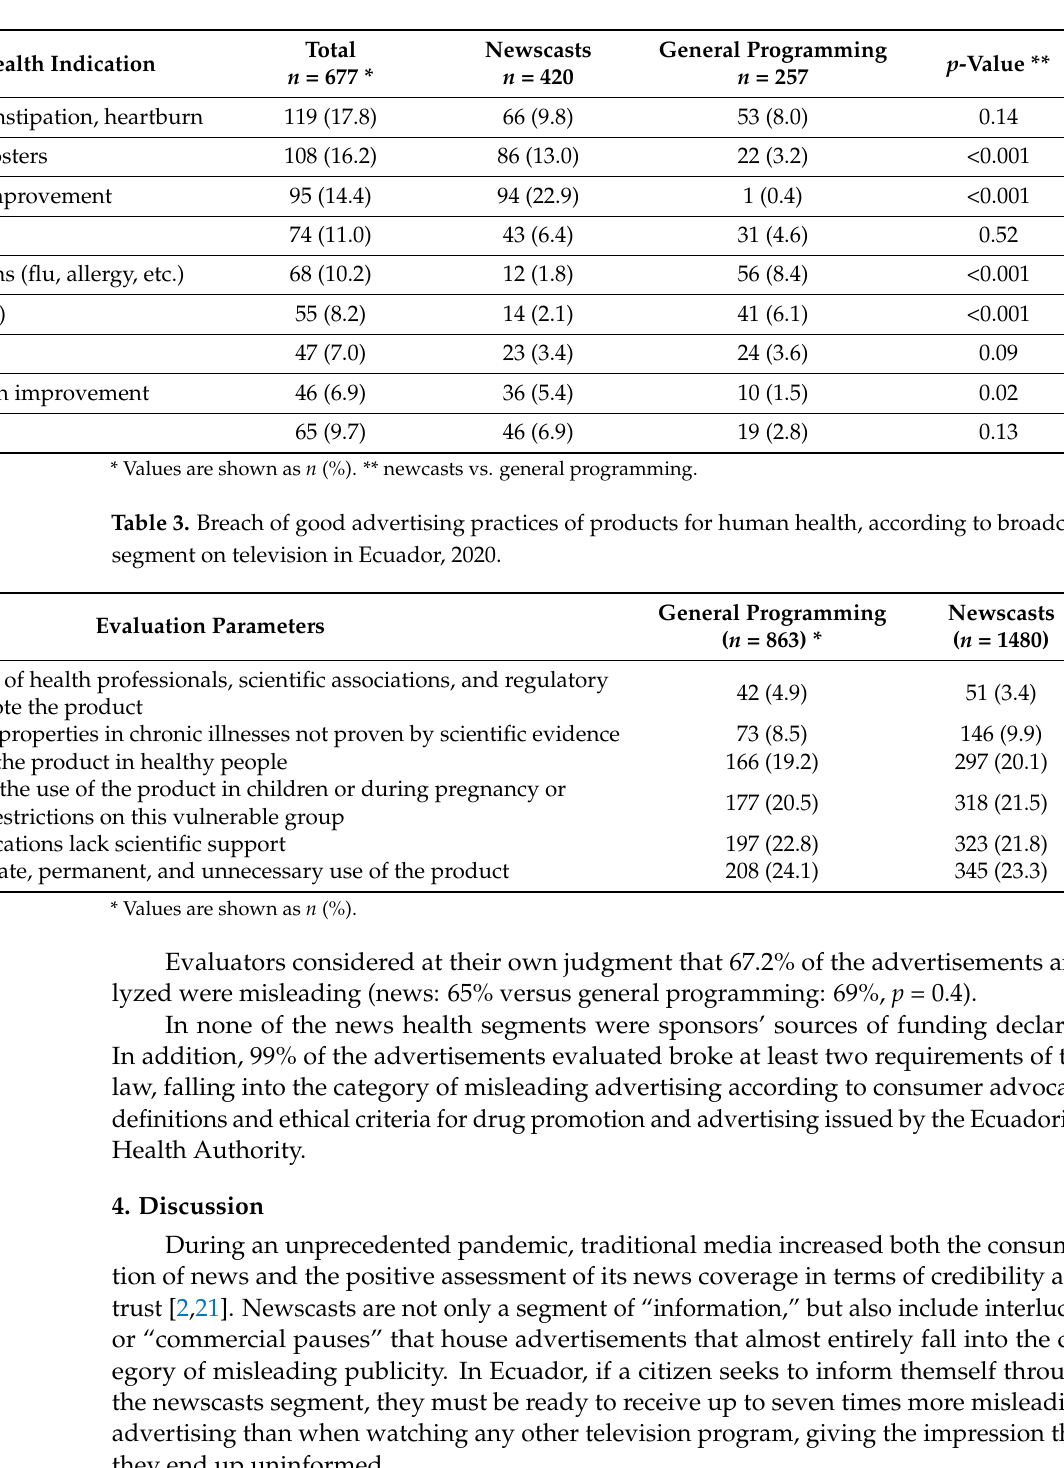
Table 2. Advertising distribution, according to the health indication advertised on television, Ecuador 2020.